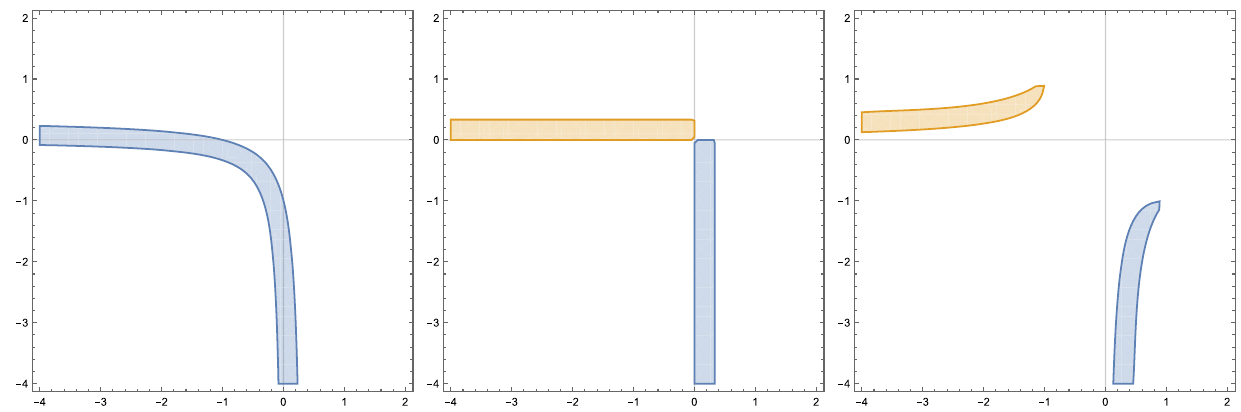
Fig. 17 Regions (blue) in the parameter space ( z 1 , z 2 ) where good AdS 3 vacua exist in SO ( 3 , 2 ) gauge group. From left to right, these figures correspond to the cases of (